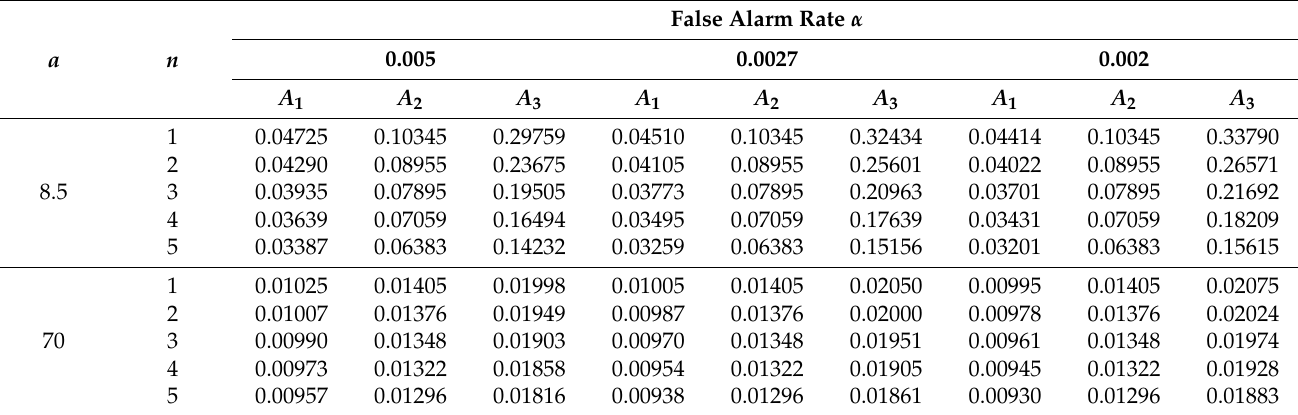
Table 1. A 1 , A 2 , and A 3 values for different n and a = 8.5,